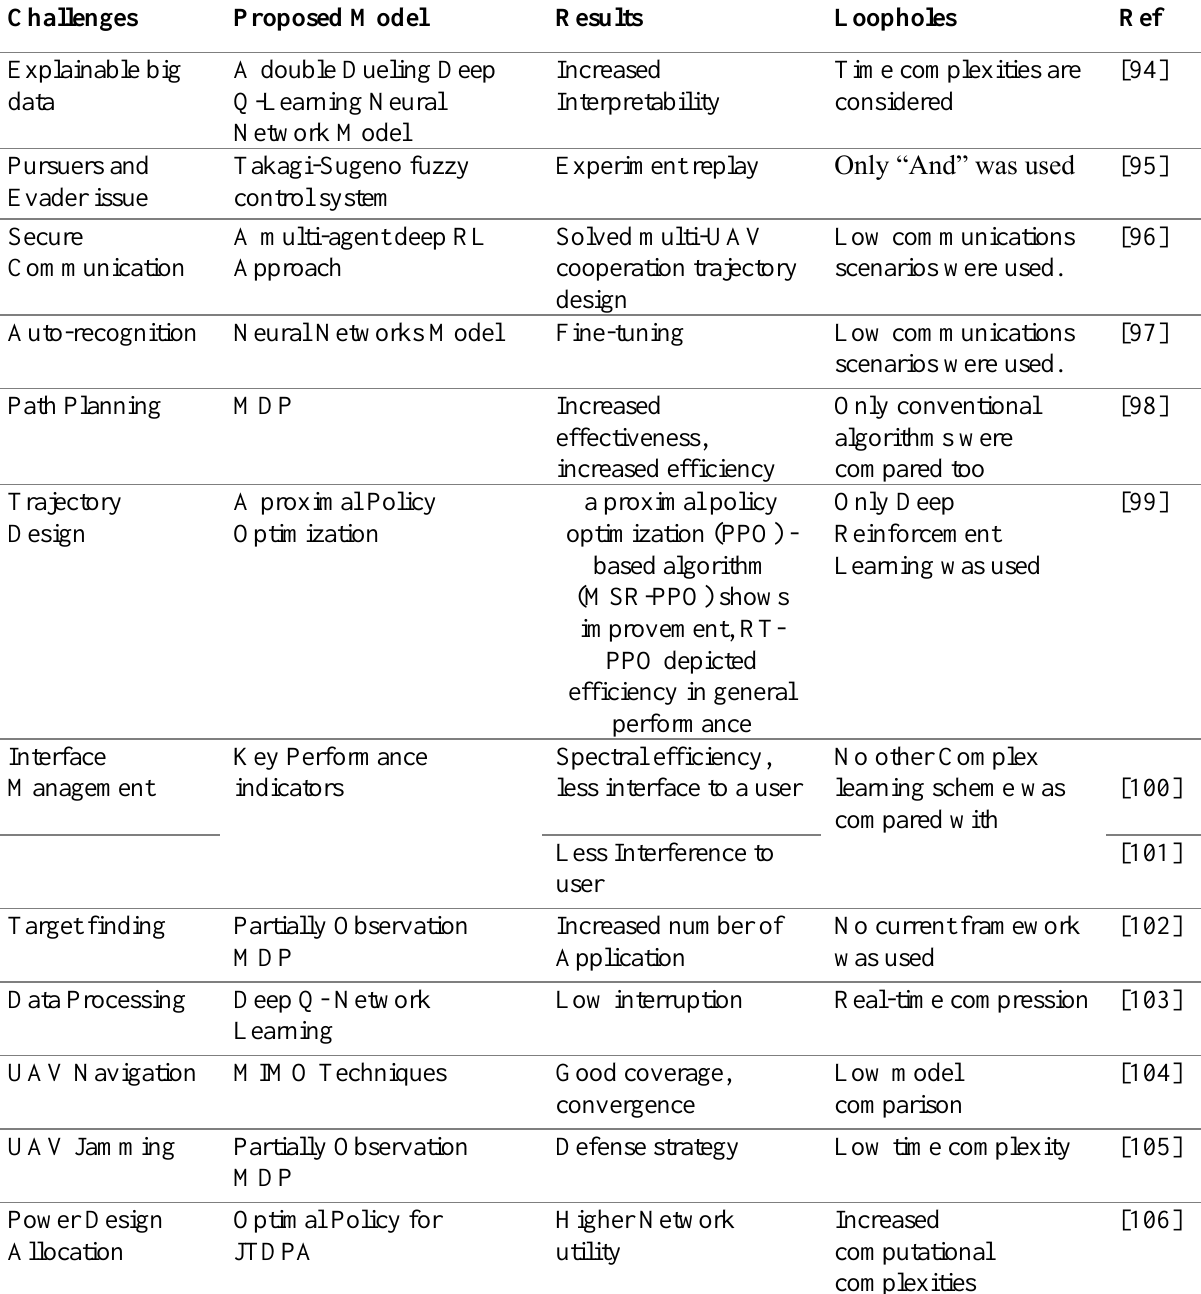
Table 4. Challenges of UAV, state-of-the-art proposed models, and